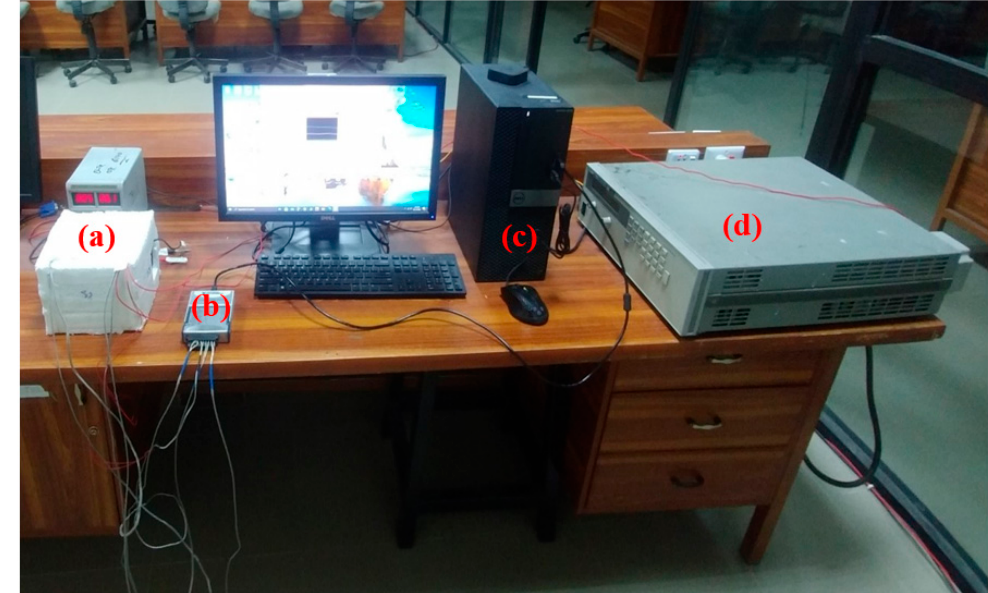
Figure 1. Experimental setup in laboratory: ( a ) Cavity; ( b ) Data acquisition system; ( c ) Data logging PC; ( d ) Power supply.